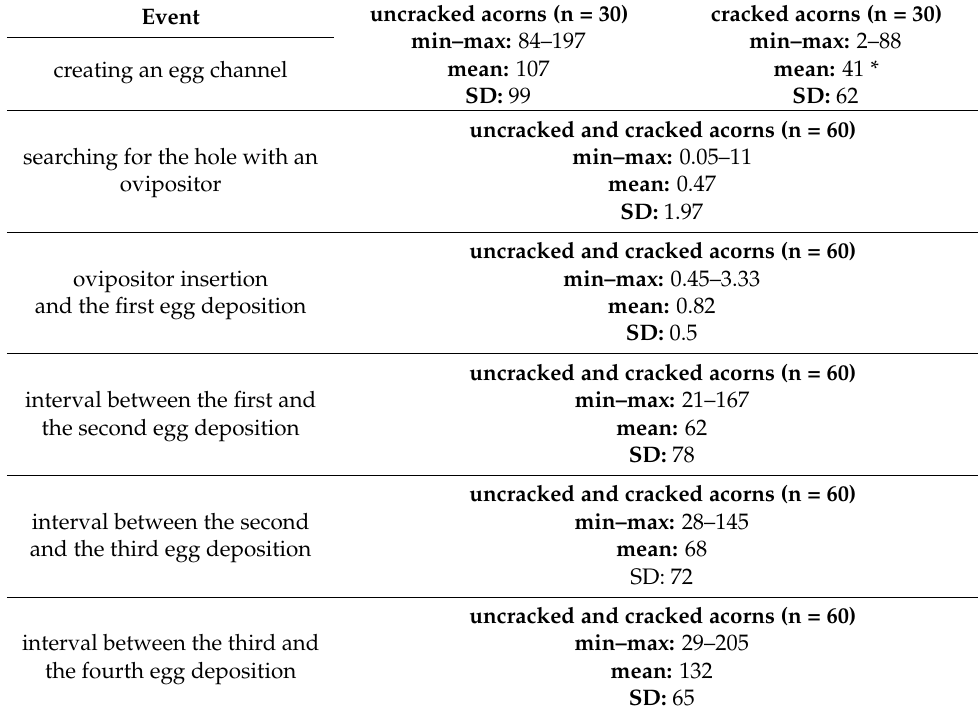
Table 3. Data on duration (minutes) of particular events during oviposition by C. glandium females offered cracked and uncracked oak